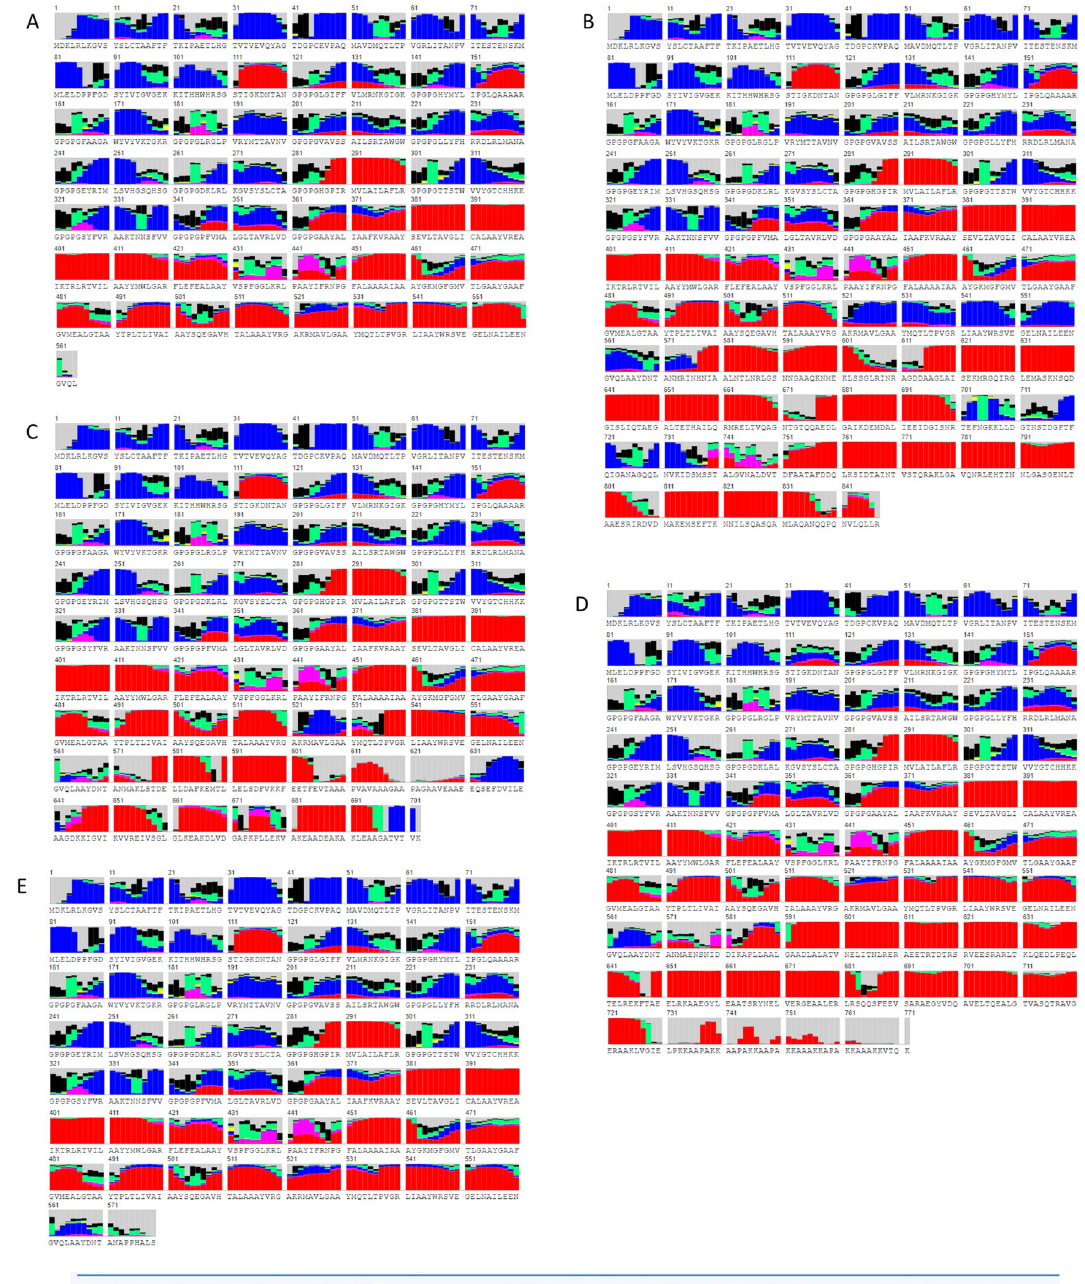
Figure 3. Secondary structure of the vaccine protein alone ( A ) and in association with adjuvants ( B–E ). Helices, coils and beta-sheets are specified in the legend, to note: alpha helix in red, 3-helix in magenta, 5-helix (pi helix) in orange, extended strand in beta ladder in blue, isolated beta bridge in yellow, hydrogen bonded turn in green, bend in black and coil in gray. ZIKVac + Flagellin ( B ), 50S ribosomal ( C ), HBH ( D ), RS09 ( E Validation of refined tertiary structures showed that all constructs had between 91.0 and 92.7% of residues in favored regions. ZIKVac, ZIKVac + Flagellin and ZIKVac + 50S Rib presented 2.5%, 2.8% and 2.9% of residues in outlier regions, respectively, while HBH and RS09 increased the percentage of residues in outlier regions to 3.6% and 3.3%, respectively (Fig. 5). Continuous and discontinuous B‑cell epitopes visualization. Prediction of conformational B cell epitopes from the refined model of ZIKVac were obtained with Ellipro and revealed ten discontinuous epitopes (Fig. 6) and fourteen continuous B cell epitopes (Table 4). The three best continuous and the best and third best discontinuous epitope scores were located at EDIII, corroborating with previous findings that this domain is a good antibody inducer.